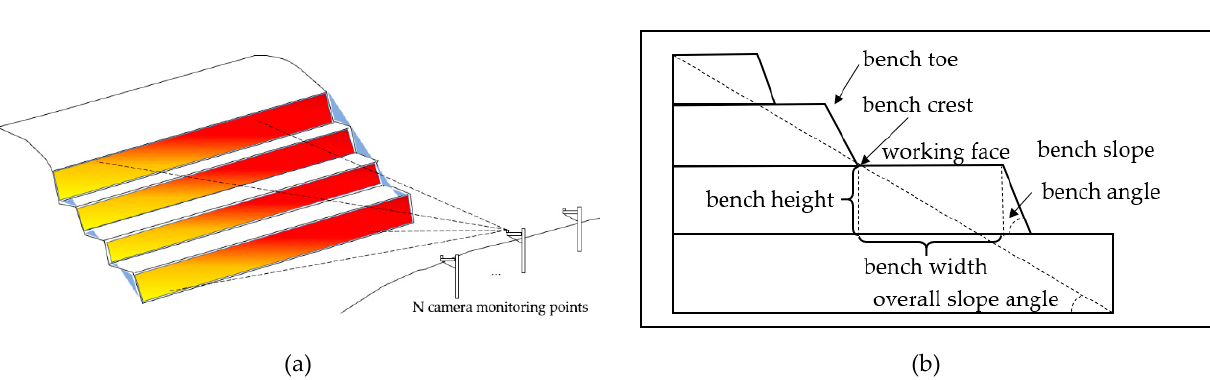
Figure 2. Schematic diagram of the monitoring object. ( a ) Schematic diagram of the monitoring of the open pit slope by cameras. ( b ) Section of the mine slope with the various parts of the open-pit mining.